Question: Write a single sentence explaining what this figure depicts.
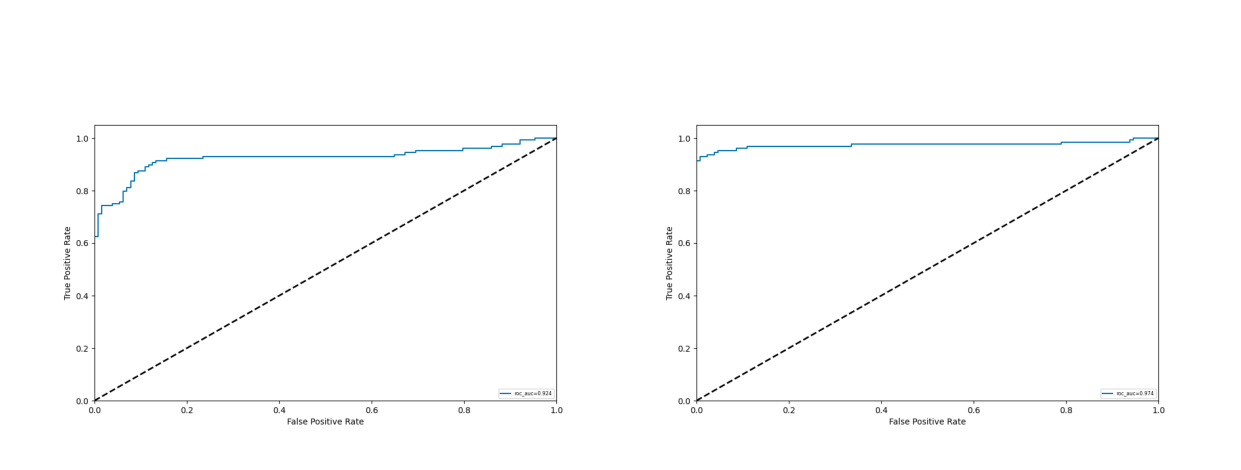
Answer: From left to right: the ROC curves for the experiment setup in Figure 4 for the original model and the unlearned model. Remarkably, there is a 50% increase in the success of the adversarial attack after unlearning, from a true positive rate (TPR) of 60% to a TPR of 90%, at a false positive rate (FPR) of 0%. And there is a clear difference on FPR in the FNR region [0, 0.2], which includes the regions we should attend to, according to Carlini et al (Carlini et al., 2022a).